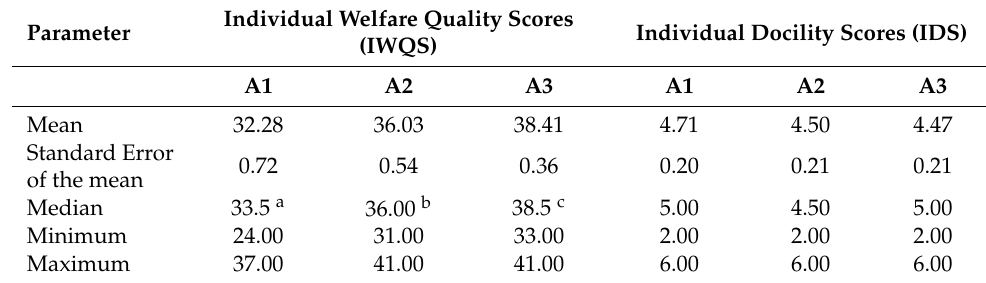
Table 4. Descriptive statistics of the individual welfare quality and docility scores in the assessed stallions in each of the three assessments